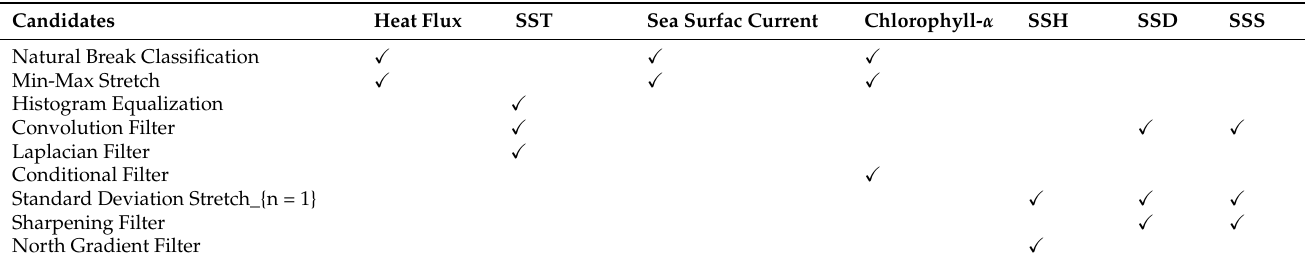
Table 1. Overview of filters used for each parameter to delineate the